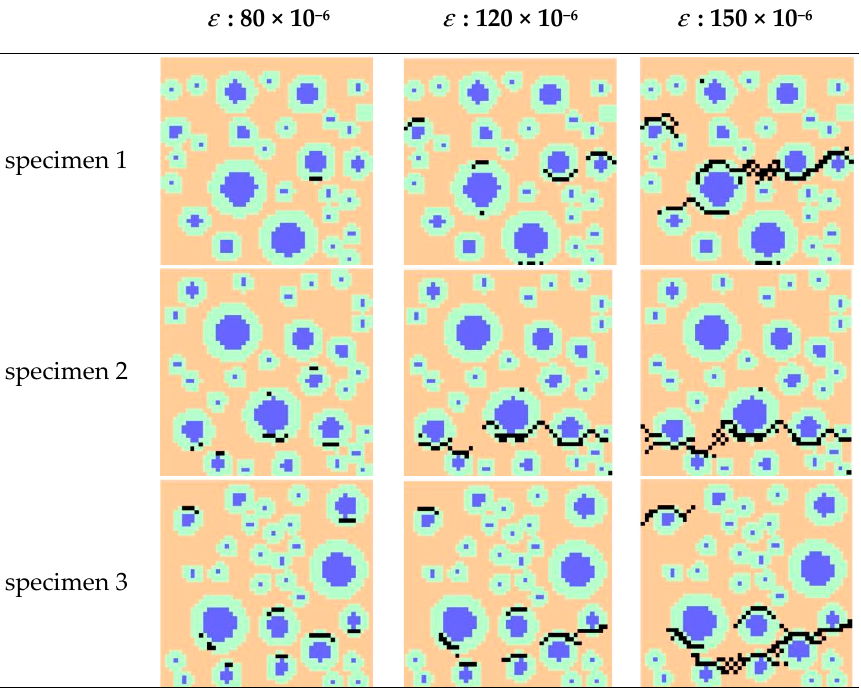
Figure 10. Damage diagram of uniaxial tension numerical simulation.